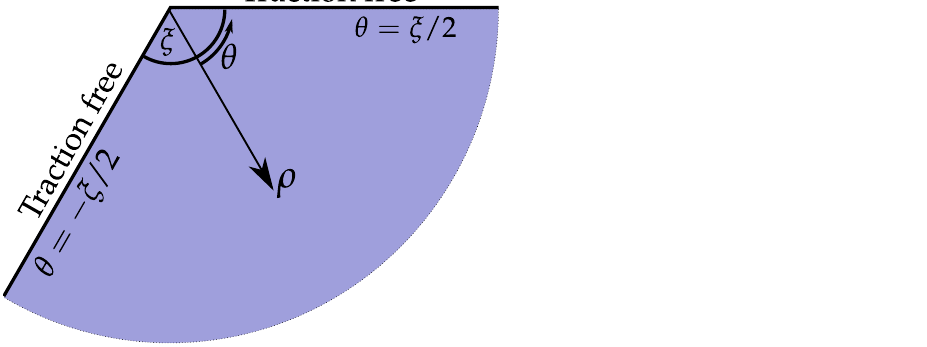
Figure 4. A general traction-free elastic corner. The elastic body is the shaded area extending to